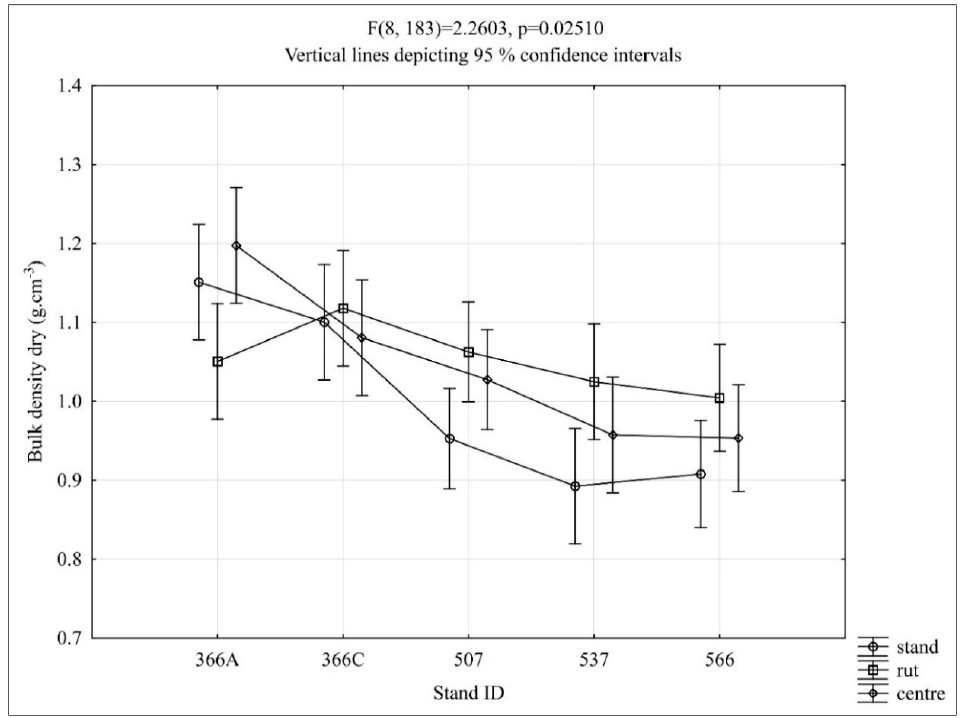
Figure 5. Analysis of differences in average bulk density of dried soil samples between individual stands and measurement locations.